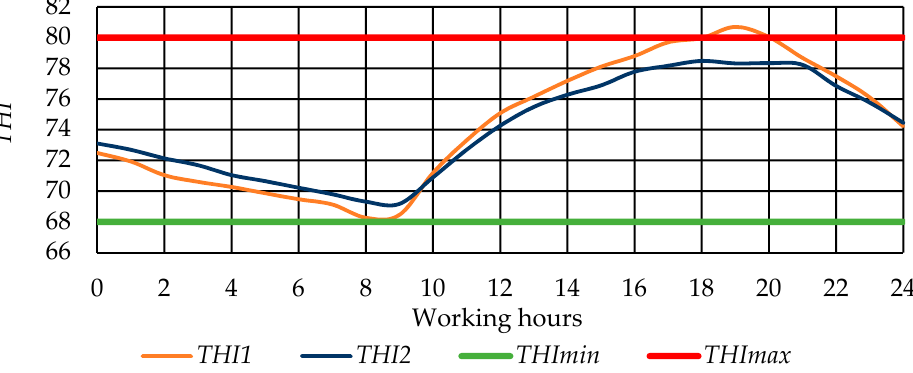
Figure 13. THI dynamics on a hot day (maximum temperature of 32.2 °C ).